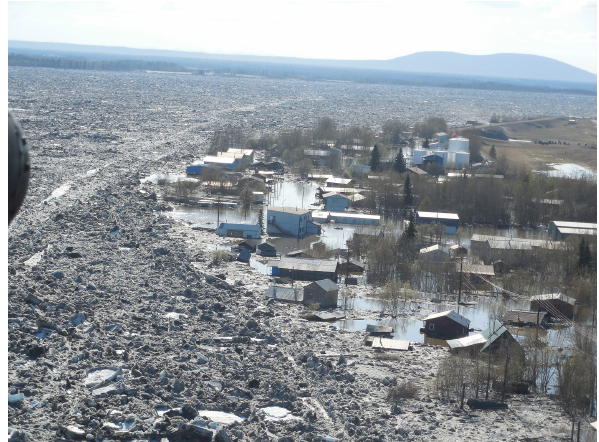
Figure 1. An aerial view shows the extent of the ice and water flooding into Galena from the Yukon